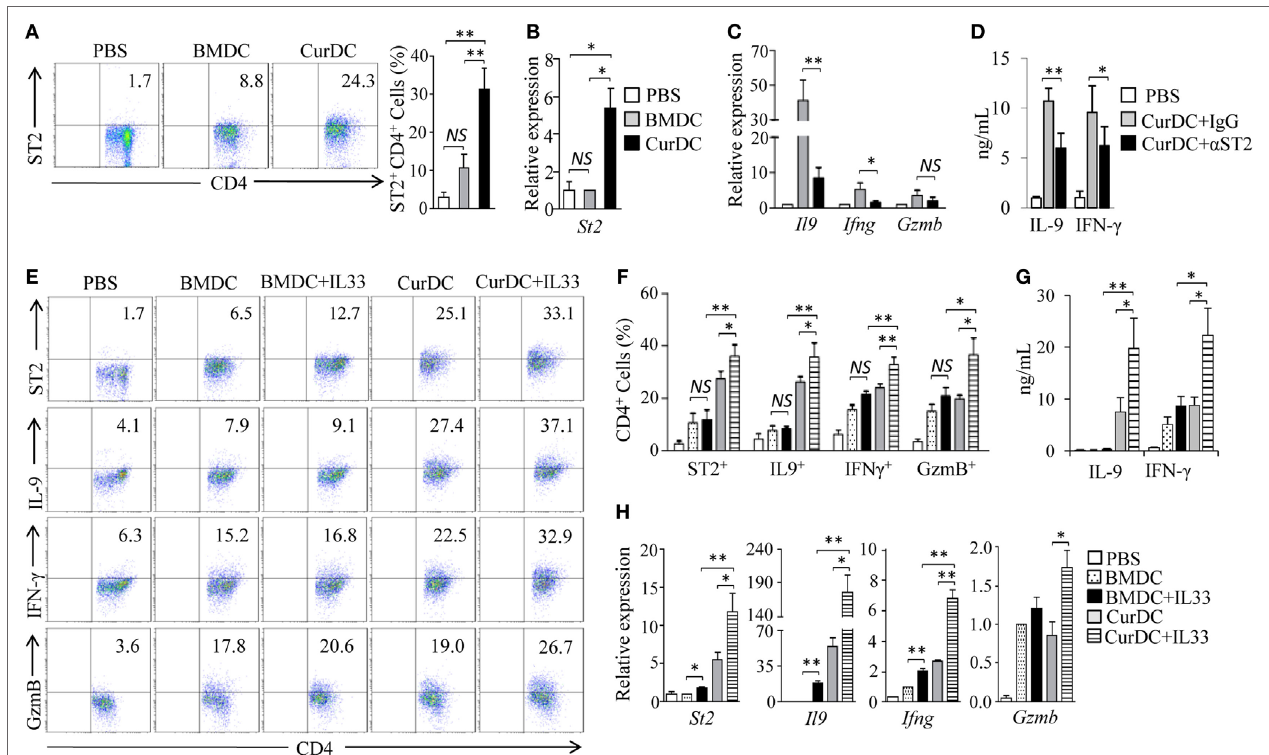
FigUre 3 | Interleukin (IL)-33/ST2 axis contributes to dectin-1-activated dendritic cell (DC)-induced Th9 priming in vivo . (a,B) OT-II mice (two to three mice/ group) were immunized twice (1 week apart) with OVA-peptide-pulsed BMDCs or CurDCs. PBS served as a control. On day 3 after the second immunization, spleen cells were harvested and restimulated separately with OVA-peptide-pulsed BMDCs and CurDCs for 2 days in the culture. (a) Flow cytometry of ST2- expressing CD4 + T cells. Numbers in the dot plots represent the percentages of ST2 + CD4 + T cells. Right, summarized results of three independent experiments obtained as at left. The experiments were performed three times ( n = 3). (B) Quantitative polymerase chain reaction (qPCR) analysis of St2 in CD4 + T cells. The experiments were performed three times ( n = 3). (c,D) OT-II mice (two to three mice/group) were immunized twice (1 week apart) with OVA-peptide-pulsed CurDCs in the presence of control IgG or α ST2. PBS served as a control. On day 3 after the second immunization, spleen cells were restimulated separately with OVA-peptide-pulsed CurDCs plus IgG or α ST2 for 48 h. (c) qPCR analyses of Il9 , Ifng , and Gzmb in CD4 + T cells. The experiments were performed three times ( n = 3). (D) Enzyme-linked immunosorbent assay (ELISA) assessed IL-9 and IFN- γ in the cultures. The experiments were performed three times ( n = 3). (e–h) OT-II mice (two to three mice/group) were immunized twice (1 week apart) with OVA-peptide-pulsed BMDCs or CurDCs. In addition, some of the mice immunized with BMDCs or CurDCs were given IL-33 (250 ng/mouse) every 3 days, beginning on the day of the first immunization. Mice received PBS served as controls. Mouse spleen cells were restimulated with BMDCs or CurDCs in the presence or absence of IL-33 (50 ng/mL) for 2 days in the culture. (e) Flow cytometry of ST2-, IFN- γ -, IL-9-, or GzmB-producing CD4 + T cells. Numbers in the dot plots represent the percentages of double-positive T helper cells. (F) Summarized results of three independent experiments obtained in (a) . The experiments were performed three times ( n = 3). (g) ELISA assays of IL-9 and IFN- γ in the culture. The experiments were performed three times ( n = 3). (h) qPCR analyses of St2 , Il9 , Ifng , and Gzmb in CD4 + T cells. The experiments were performed three times ( n = 3). Data are representative of three (a,e) independent experiments or presented as mean ± SD of three (a–D,F–h) independent experiments. NS , non-significant; * P < 0.05; ** P < 0.01